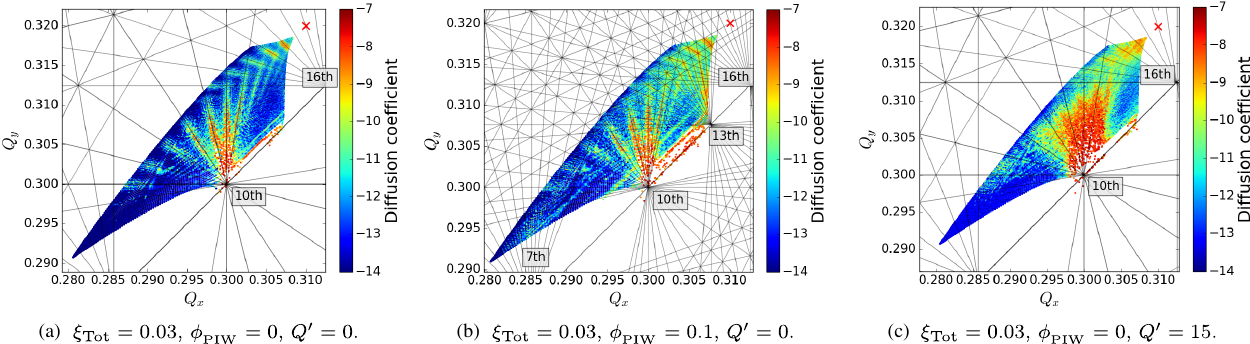
FIG. 9. FMAs showing effects of nonzero Piwinski angle and chromaticity for a working point of ð Q x ; Q y Þ ¼ ð 0 . 31 ; 0 . 32 Þ , related to the beam quality study in Fig. 8. Possible resonance lines up to the 16th order have been plotted on top of the tune footprint in each figure. A few labels were added to guide the